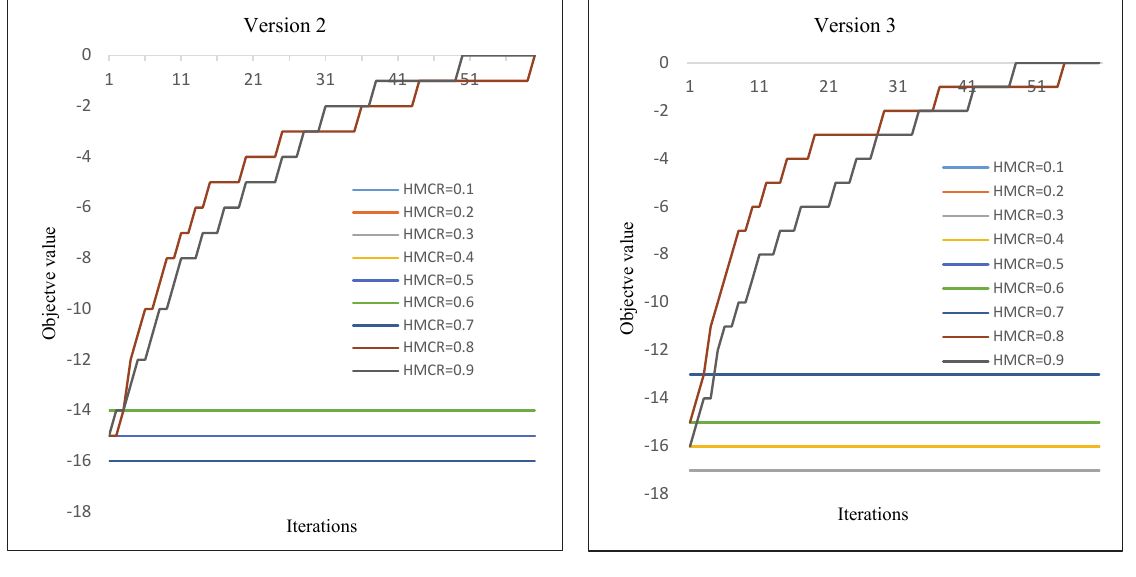
Fig. 11. Performance of algorithm for sample datasets with 100 and 200 objects (a) version 2 (b) version 3